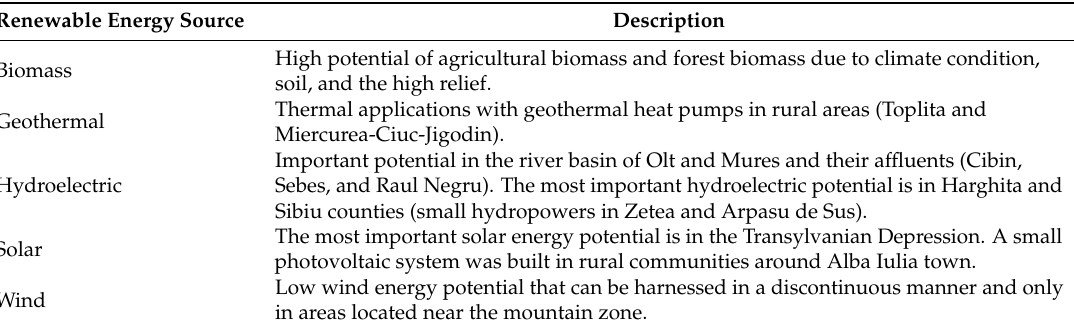
Table 2. Characteristics of renewable energy sources in CDR